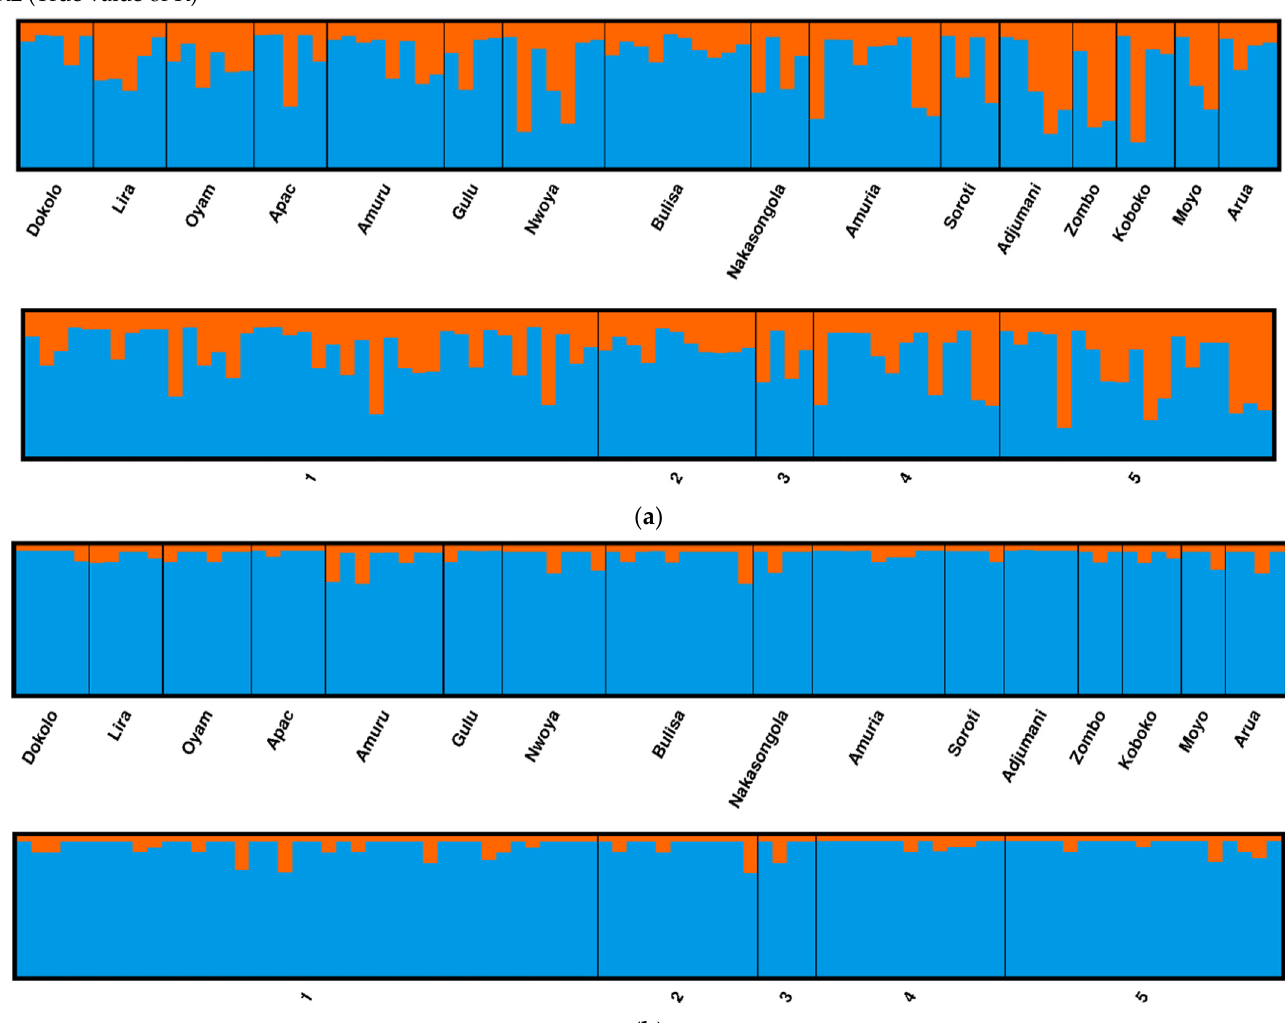
Figure 5. ( a ). Population structure across five and sixteen populations agro-ecological zones and districts respectively of Ootheca mutabilis obtained using structure (for SSR data and ( b )) for mt CO1 partial gene sequences both at K = 2. Vertical bars represent individuals. Numbers on the horizontal axis represent agro-ecological zones; (1) Northern moist farmlands (A), (2) Western mid-altitude farmlands (B), (3) Central wooden savannah (C), (4) Southern and Eastern Lake Kyoga basin (D), and (5) North-western farmlands (E).